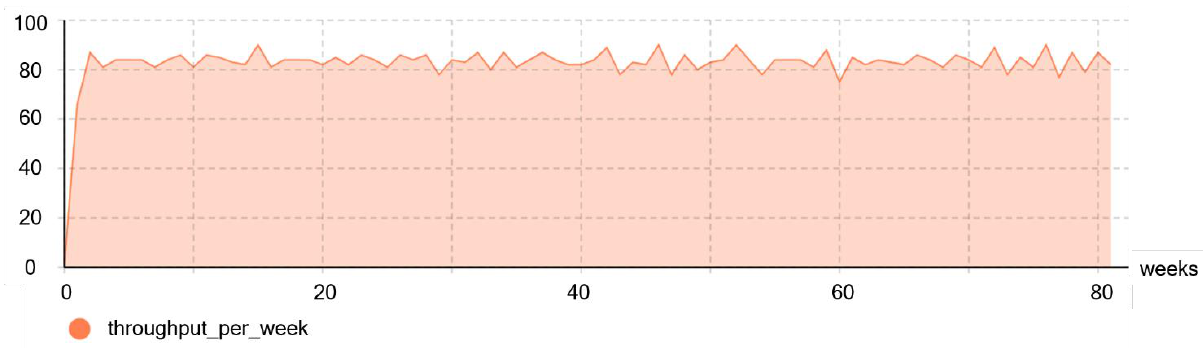
Figure 4. Throughput changes during the warmup and data collection